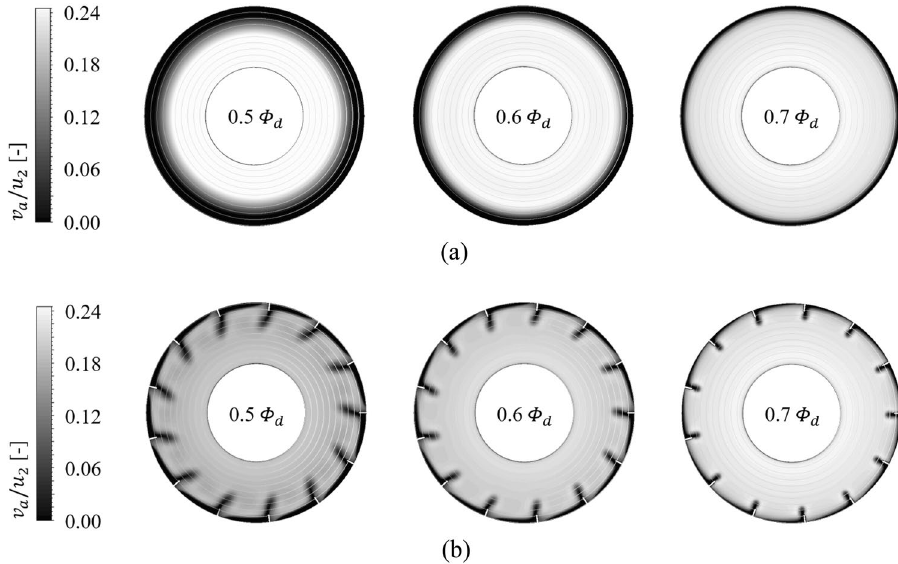
Figure 10. Axial velocity ( v a ) contour on sectional plane for each ( a ) case of none and ( b ) ASF attached (0.5–0.7 Φ d ).